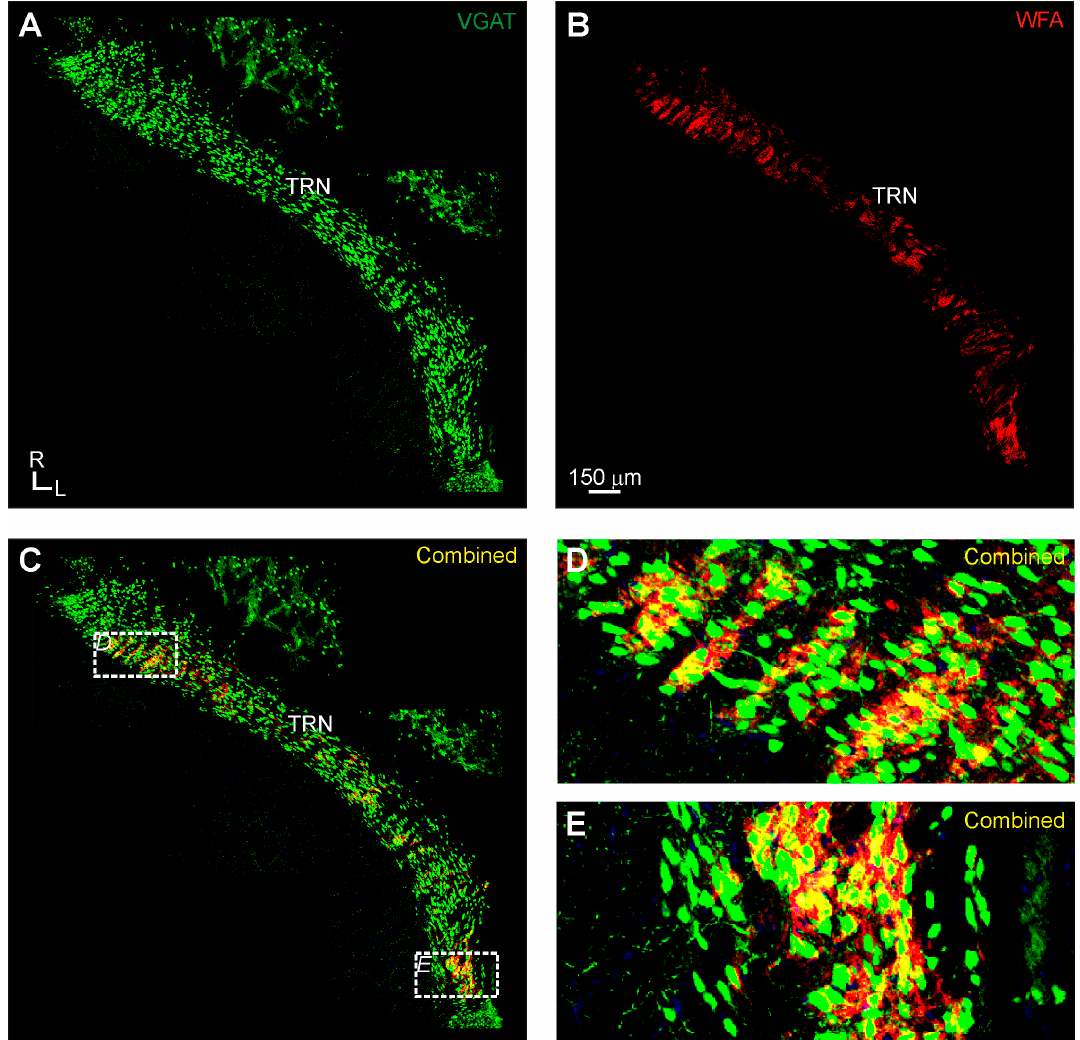
Figure 4. Perineuronal net (PNN) expression in the thalamic reticular nucleus (TRN) of the vesicular gamma-amino butyric acid transporeter (VGAT)-Venus C57BL/6 mouse strain: ( A ) the distribution of VGAT-positive neurons (green) was non-homogeneous across different portions of the TRN; ( B ) PNNs (red) were found highly clustered, forming banded regions in lateral and medial locations of the TRN, which was the main region in the thalamus where robust perineuronal net expression was found, for comparison see the medial geniculate body (MGB), lateral geniculate nucleus (LGN), and ventrobasal nuclei (VB) in Figure 3B for an overview of the paucity of wisteria floribunda agglutin (WFA) labeled perineuronal nets in these nuclei; ( C ) although all PNNs found surrounded Venus-positive cell bodies, not all Venus-positive cell bodies were surrounded by PNNs; and ( D ) higher-magnification view of boxed regions in panel C.